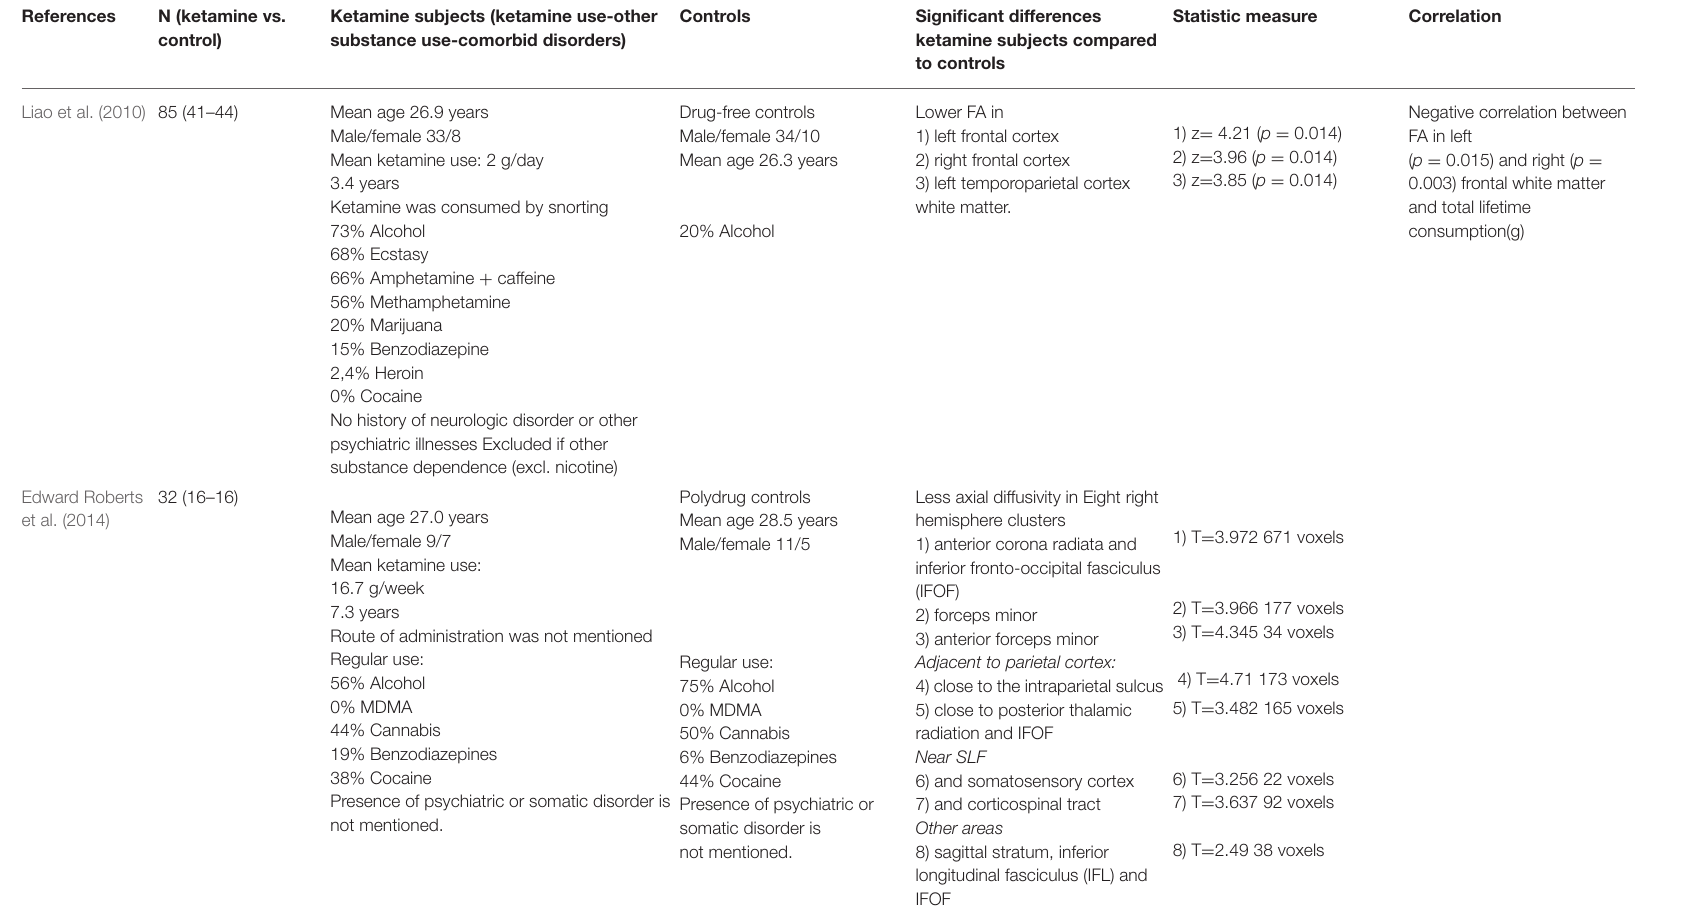
TABLE 2 | Structural differences: white